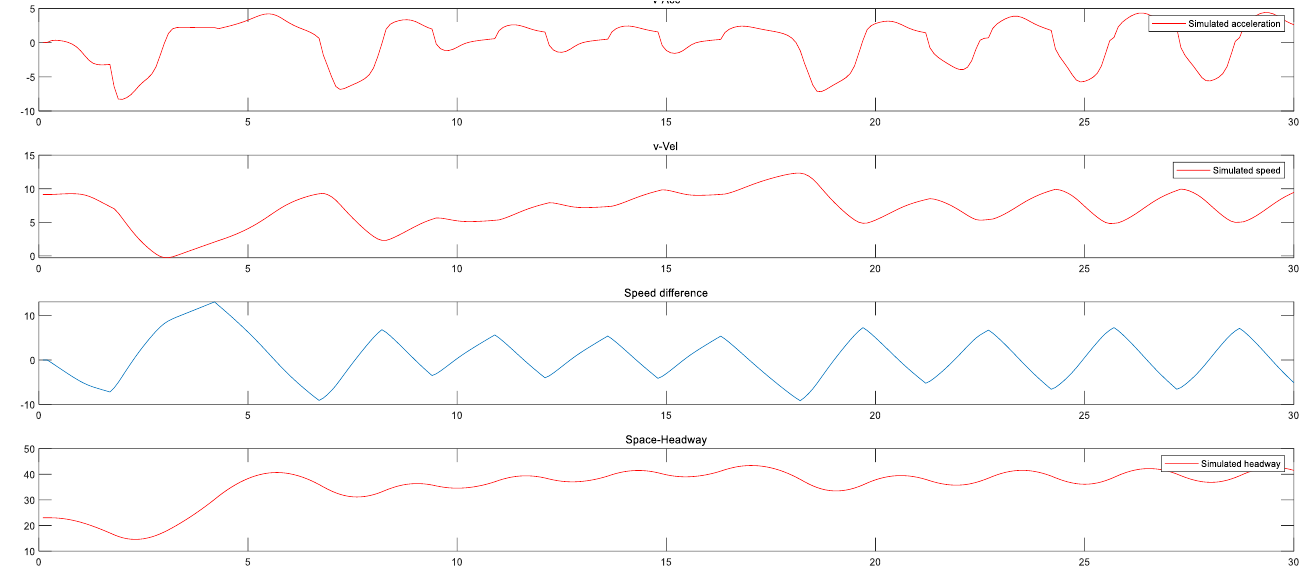
Figure 13. Simulation results of edge